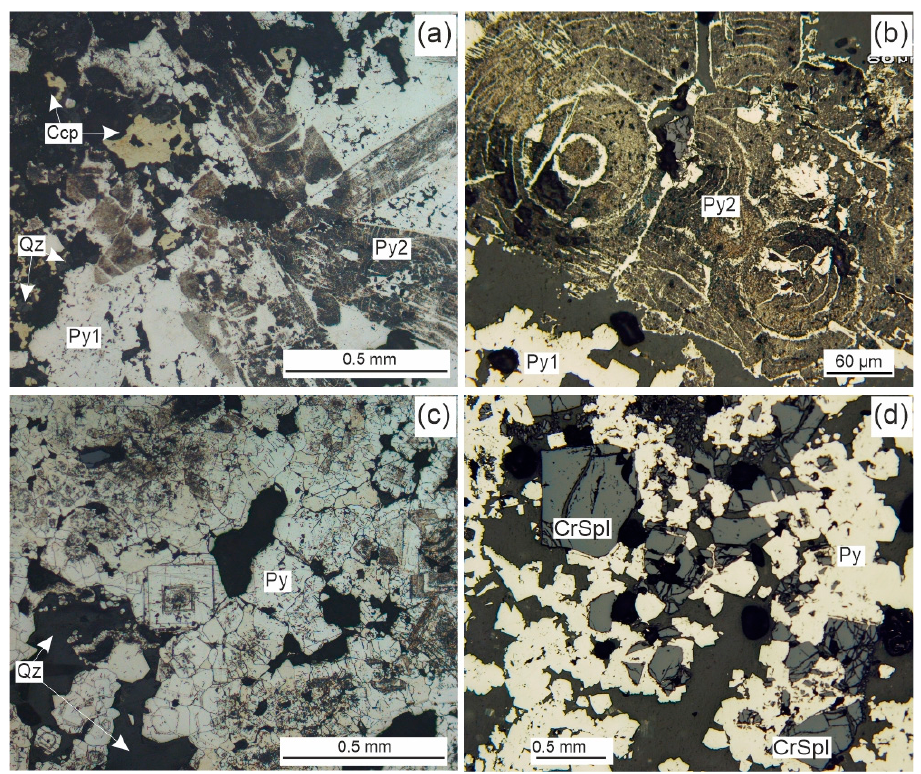
Figure 4. Microstructures of sample 242-1. ( a ) Pyrite (Py1), trace of tabular pyrrhotite completely replaced by pyrite, (Py2) and chalcopyrite (sample 242-1). ( b ) “Bird’s eye” structure in composed by Py2 (sample 242-1/1). ( c ) Zoned pyrite crystals (sample etched with concentrated nitric acid with fluorite powder) (sample 242-1/1b). ( d ) Fragmented grains of Cr-spinels in pyrite (sample 242-1/1). Table 2. Average chemical composition of sulfides from st.